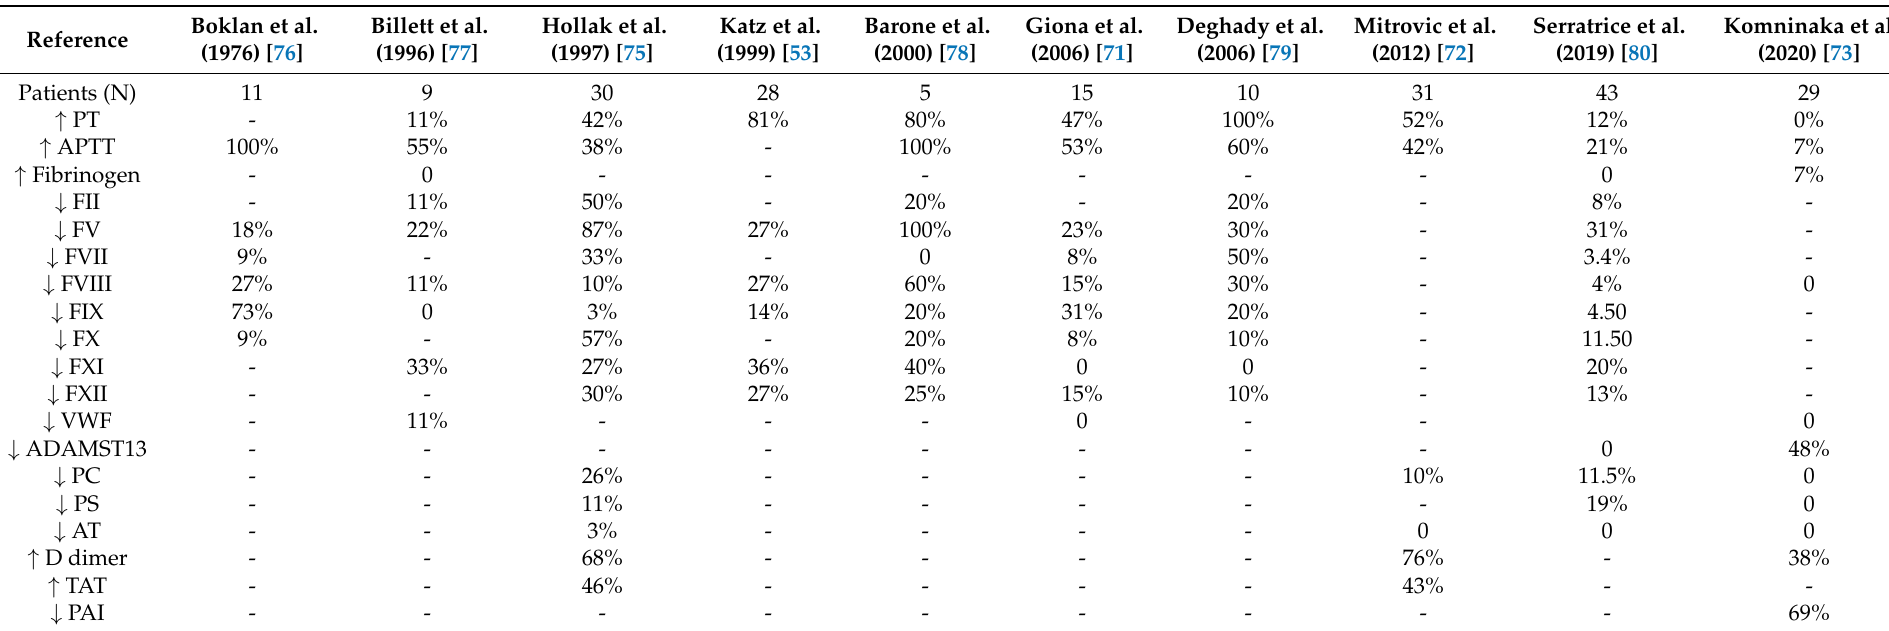
Table 3. Studies of coagulation factor abnormalities in Gaucher disease: percentage of patients in each study found to have coagulation